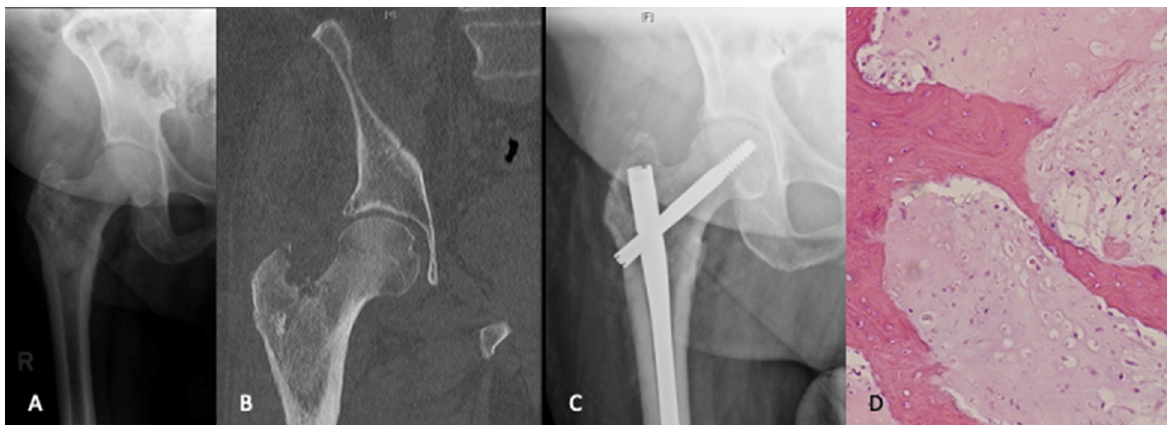
Figure 1. An 80-year-old male presented with ongoing right hip pain and lesion in the peritrochanteric region that was thought to be metastatic disease ( A , B ). A workup for an unknown primary lesion was negative. The patient underwent intramedullary nail fixation for impending pathologic fracture ( C ). The pathologic findings from intraoperative reamings were consistant with a diagnosis of chondrosarcoma (H&E, × 200). ( D ). Given the patients age and health status along with the morbidity of a curative procedure, the decision was made to pursue palliative